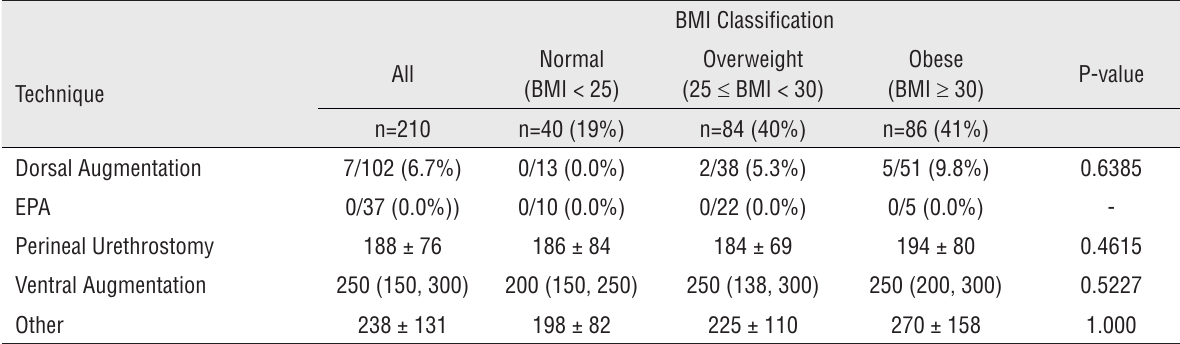
Table 3A - Complications by BMI classification and technique.